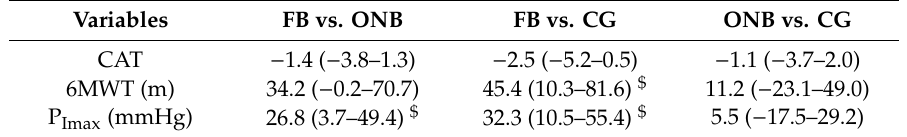
Table 2. Between-di ff erences for breathing conditions after and before pulmonary rehabilitation.